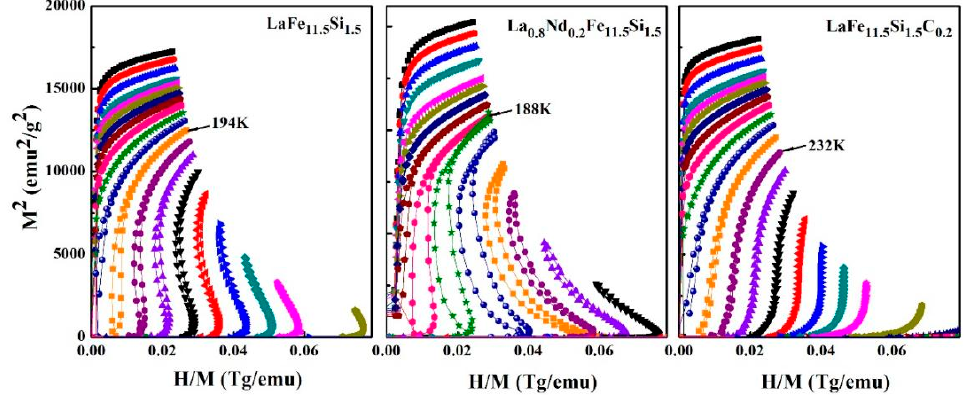
Figure 4. The Arrott plots of LaFe 11.5 Si 1.5 , La 0.8 Nd 0.2 Fe 11.5 Si 1.5 , and LaFe 11.5 Si 1.5 C 0.2 compounds.